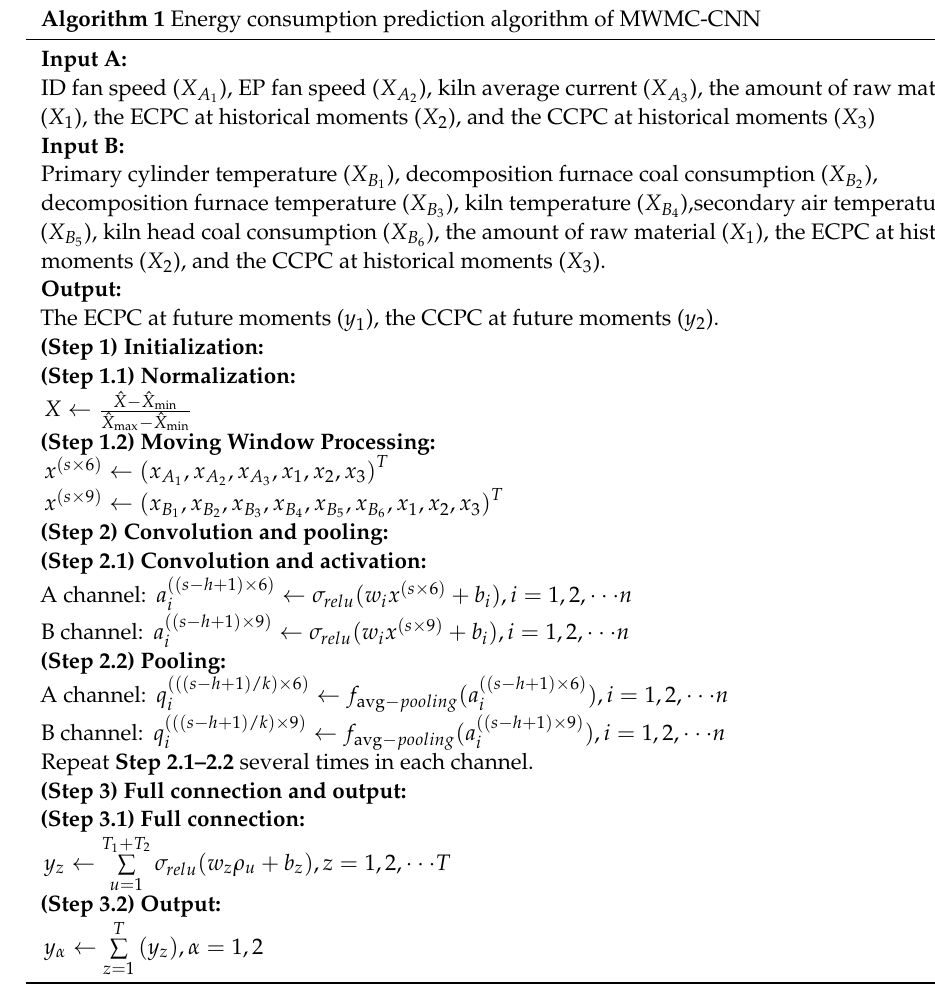
Algorithm 1 Energy consumption prediction algorithm of